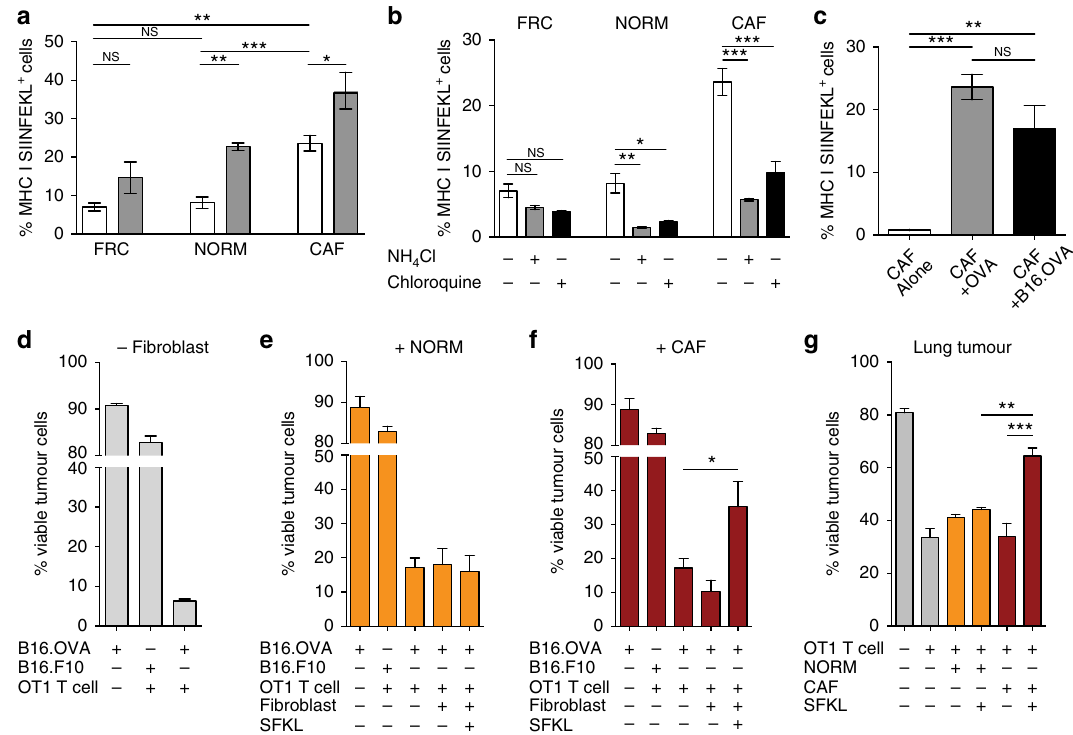
Fig. 2 CAF cross-presentation of processed antigen protects tumour cells from T cell killing. a Quanti fi cation of MHC I SIINFEKL detected in FRCs, CAFs and normal fi broblasts following OVA pulse (white bars), and when pulsed in tumour conditioned media (grey bars). b MHC I SIINFEKL detection in the presence of ammonium chloride (grey bars), chloroquine (black bars) and vehicle control (white bars). c MHC I SIINFEKL detected on CAFs after co culture with B16.OVA tumour cells, or CAFs pulsed with soluble OVA. d T cell killing of control parental (B16.F10) and antigen bearing (B16.OVA) target tumour cells in the absence of fi broblasts. e , f B16 viability when introduced to OT-I T cells previously conditioned in the presence/absence of normal fi broblasts ( e ), CAFs ( f ) and presence/absence of antigen as indicated on graphs. g Lung tumour cell viability when introduced to OT-I T cells previously conditioned in the presence/absence of normal fi broblasts (yellow bars), CAFs (red bars) and presence/absence of antigen as indicated on graphs. Data shown as mean ± SEM. * p < 0.05, ** p < 0.01 and *** p < 0.001, one-way ANOVA with Tukey post hoc analysis. NS, not signi fi cant. Assays performed in triplicate ( a , c , g ) or duplicate ( b ) from two experiments or ( d - f ) three experiments. Comparisons indicated by horizontal